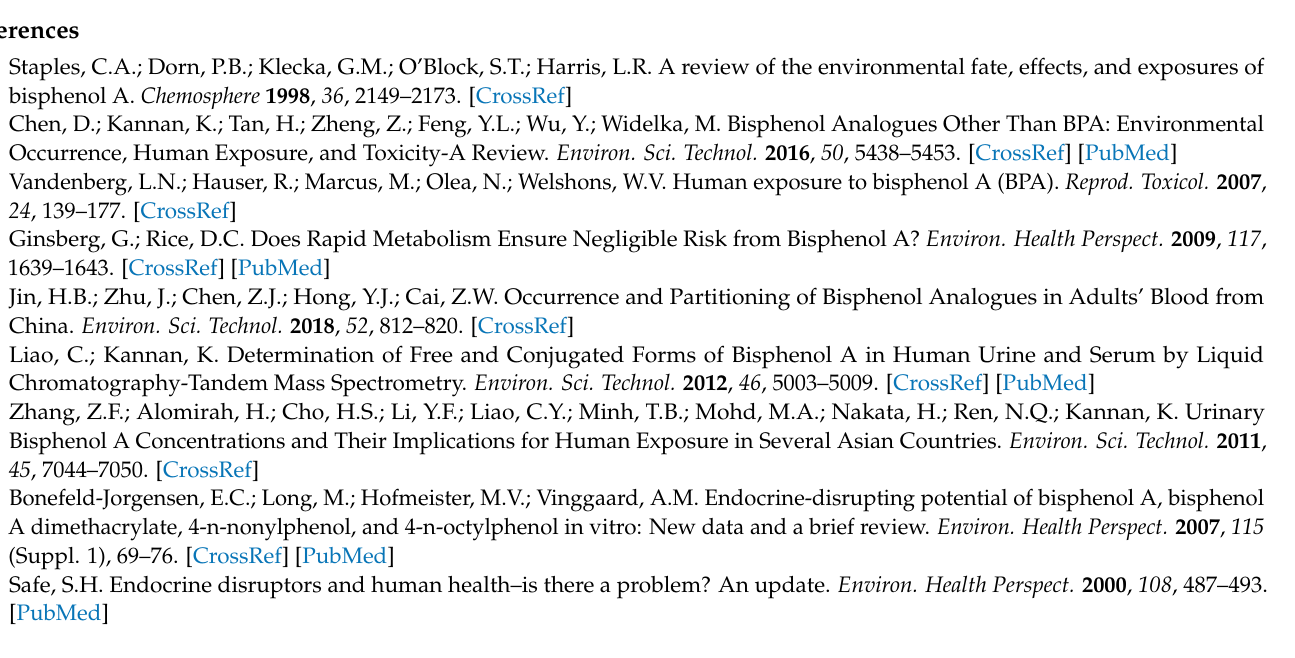
Figure S1. Typical chromatograms and molecular structures of BPA and its conjugate metabolites. Figure S2. Change in the alpha diversity (Chao1 estimator and Shannon index) of rat gut microbiota with time, following (a) interval and (b) continuous oral BPA exposure. An independent sample t -test was used to determine the differences between the Chao1 estimator and Shannon index from day 0 to day 28. The * means that the difference was significant ( p < 0.01). Figure S3. Principal coordinate analysis of the gut microbiome patterns of rats at day 1 and 29 following (a) intervallic and (b) continuous oral BPA exposure. Figure S4. Amount of BPA ( µ g; mean ± SD) excreted via the rats’ urine and feces, following (a) intermittent and (b) continuous BPA exposure. Note that BPA conjugates were transferred to BPA based on the method of previous studies.2, 3 BPA excreted in glucuronide form = BPA-G × 0.5614; BPA excreted in sulfate form = BPA-S × 0.7404. The factors 0.5614 and 0.7404 are the ratios of the molecular weight of BPA to the molecular weights of BPA-G and BPA-S,